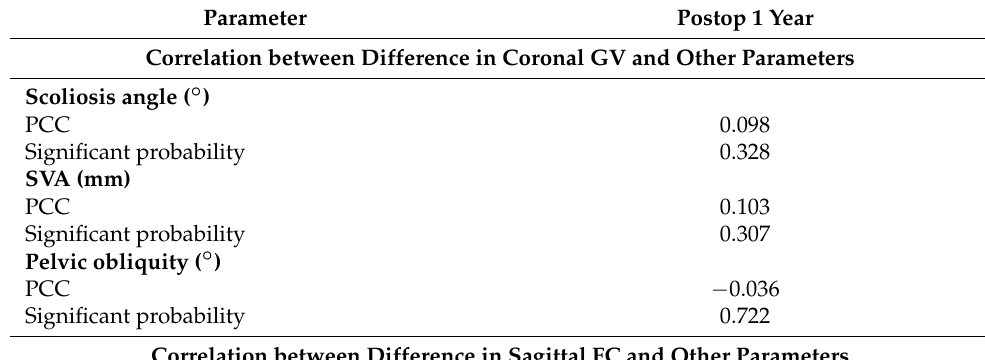
Table 5. Correlation analysis between difference in GV/FC and other parameters.